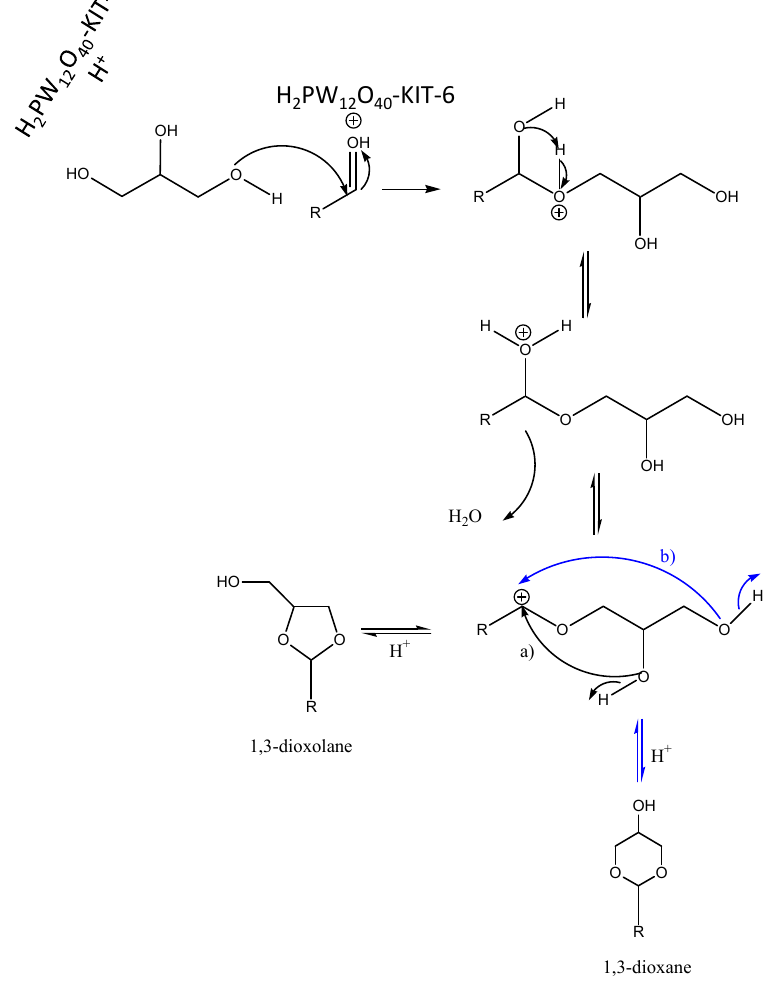
Figure 13. Mechanistic proposal exemplified for the glycerol acetalization with citral over PW4-K-6, leading to the 1,3-dioxolane or 1,3-dioxane acetal products (where R = —CH=C(CH 3 )CH 2 CH 2 CH=C(CH 3 )(CH 3 )).